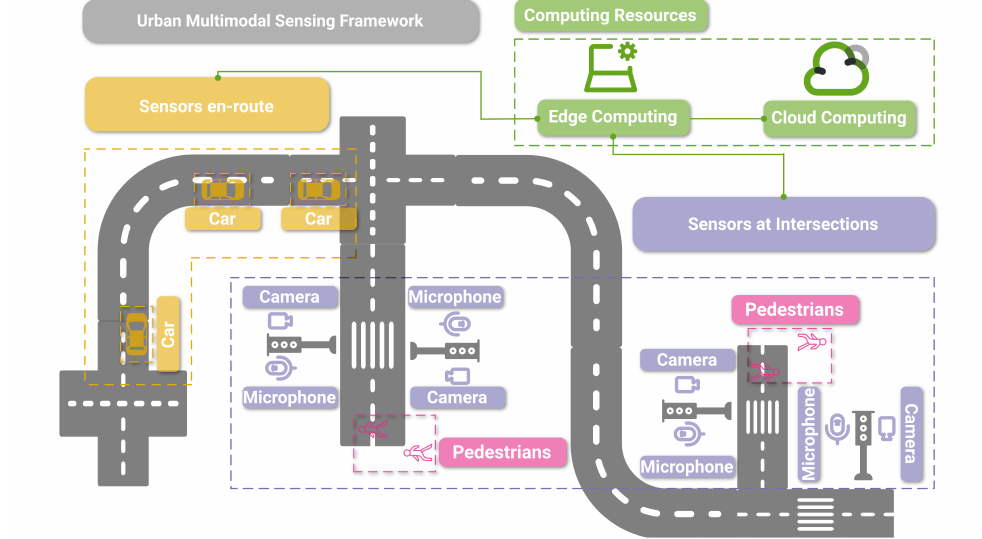
Figure 1. Illustration of the basic concept of combining multimodal sensors at critical nodes (e.g., intersections) with on-device and in-vehicle computing capabilities to provide greater awareness to urban traffic